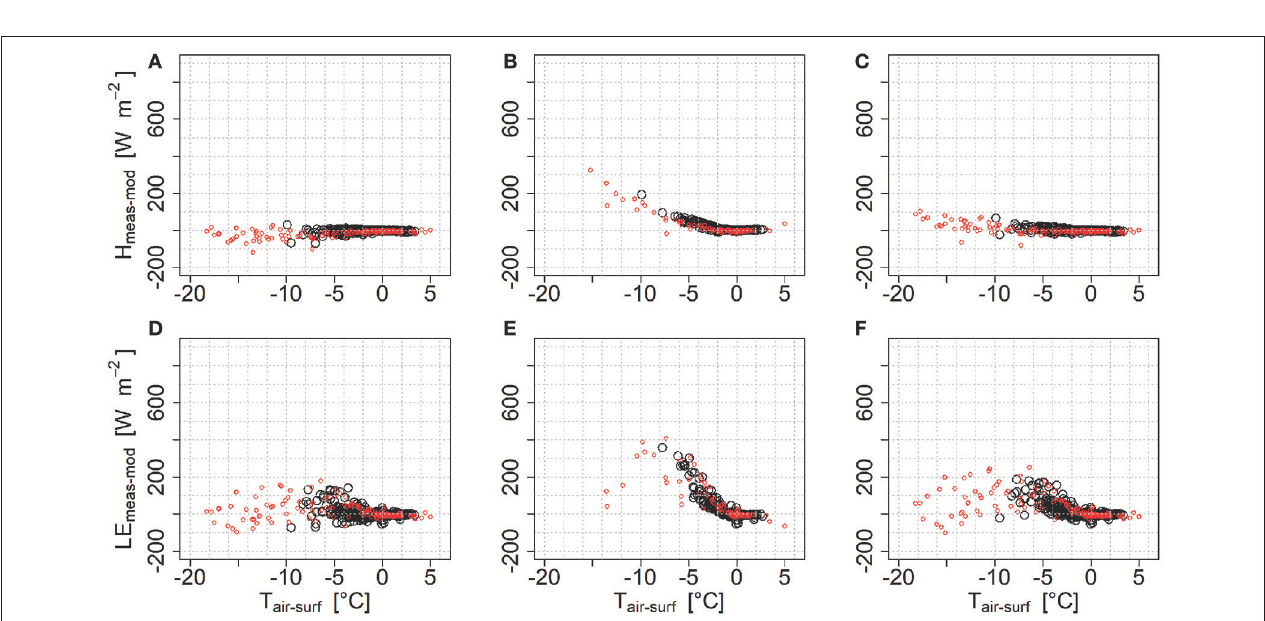
FIGURE 9 | Diurnal cycles for all model results on all days (A,D) , overcast days (B,E) and clear sky days (C,F) for sensible (A–C) and latent heat flux (D–F) . EC denotes the eddy correlation measurements, nSC the model with no stability correction, rSC based on the Richardson number and iSC iterating over the Monin-Obukhov length. Timesteps with no data for a model are cases where all values were below –500 W m − 2 .